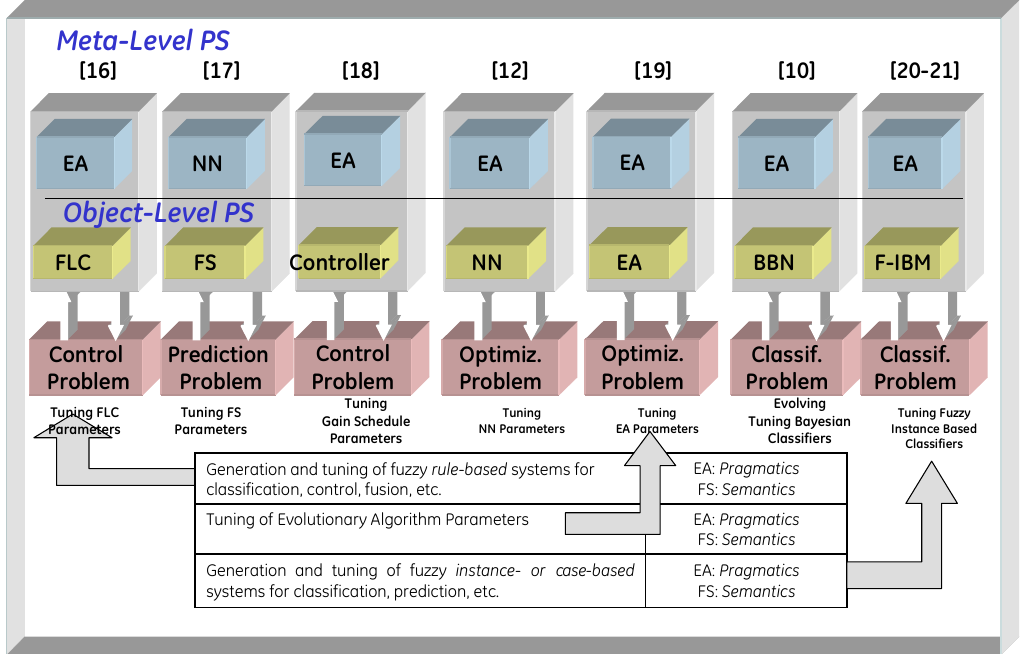
Fig. 5. Example of Offline Meta-Heuristics (adapted from reference 15).